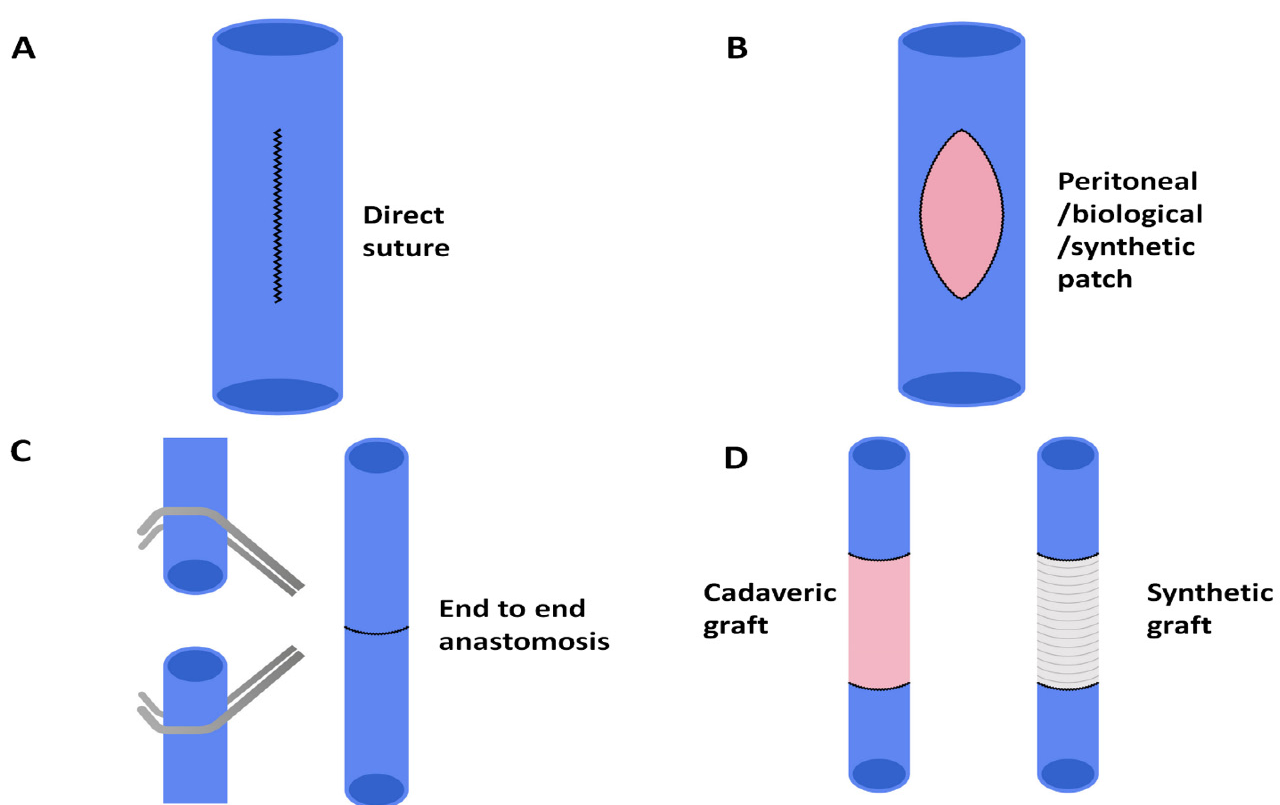
Figure 2. Reconstructive options after IVC resection. ( A ) Direct suture is possible when resection involved less than 120° of the IVC wall. Transverse repair (not depicted) may be used to lower chances of stenosis for long longitudinal defects. ( B ) Patch repair can be used when less than 180° of the IVC has been resected. Peritoneal, biological and synthetic options exist. ( C ) End-to-end anastomosis can be fashioned for circumferential IVC resection <3 cm in length. ( D ) Interpositional grafts are the preferred option for defects longer than 3 cm and autologous, cadaveric and synthetic grafts have been used.